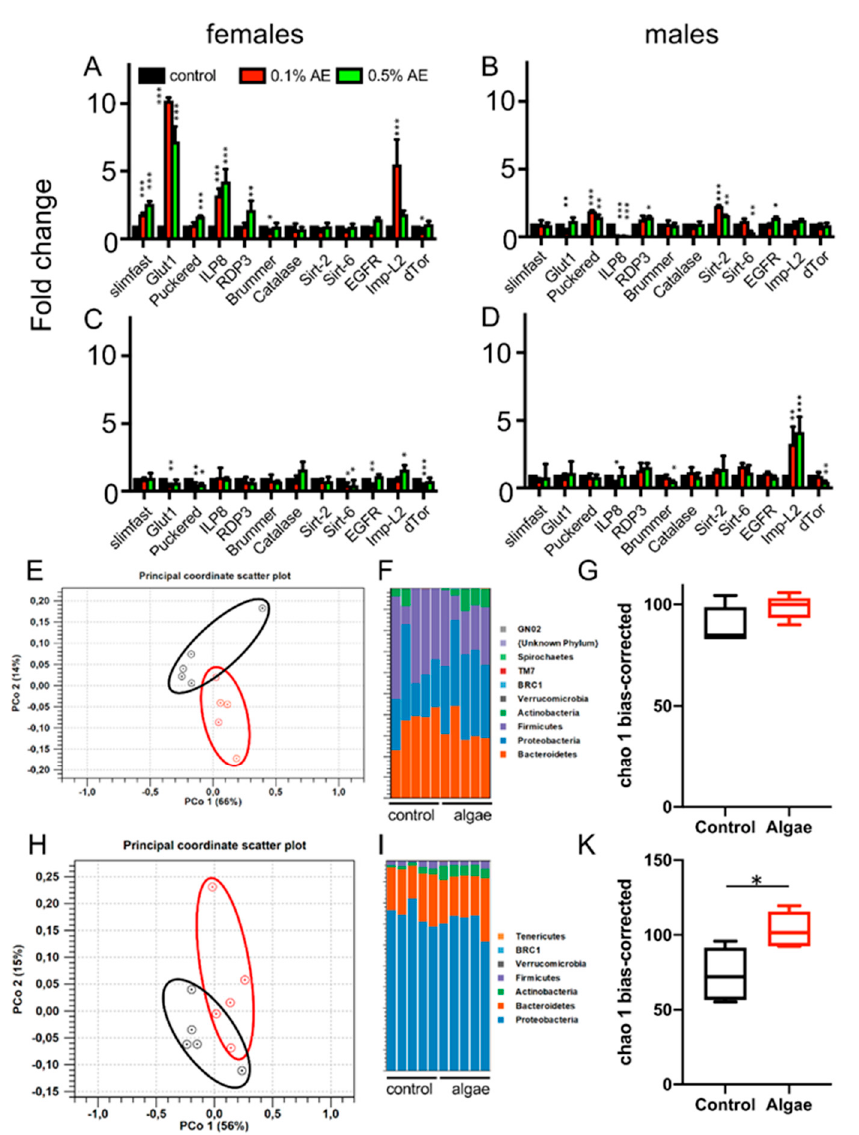
Figure 6. Transcript levels of selected genes in females ( A , C ) and males ( B , D ) subjected to 7 d of BAE-supplemented food ( A , B ) or 14 d of BAE-supplemented food ( C , D ); 0.1% AE (red bars) and 0.5% AE (green) are shown together with matching controls. Effects of BAE on the composition of the intestinal microbiota of w 1118 animals ( E–K ). Analyses of 16S rRNA genes of isolated intestine ( E–G ) and of fecal samples ( H–K ) were done with 5 biological replicates for both controls and those treated with 0.1% BAE, respectively. PCoA analysis of the samples derived from the intestinal ( E ) and fecal ( H ) samples. Composition of the intestinal ( F ) and fecal ( I ) microbiota is given. The species richness (alpha diversity) is shown in ( G ) and ( K ) for intestinal and fecal samples, respectively. n = 5, * p < 0.05, ** p < 0.01, *** p < 0.001.